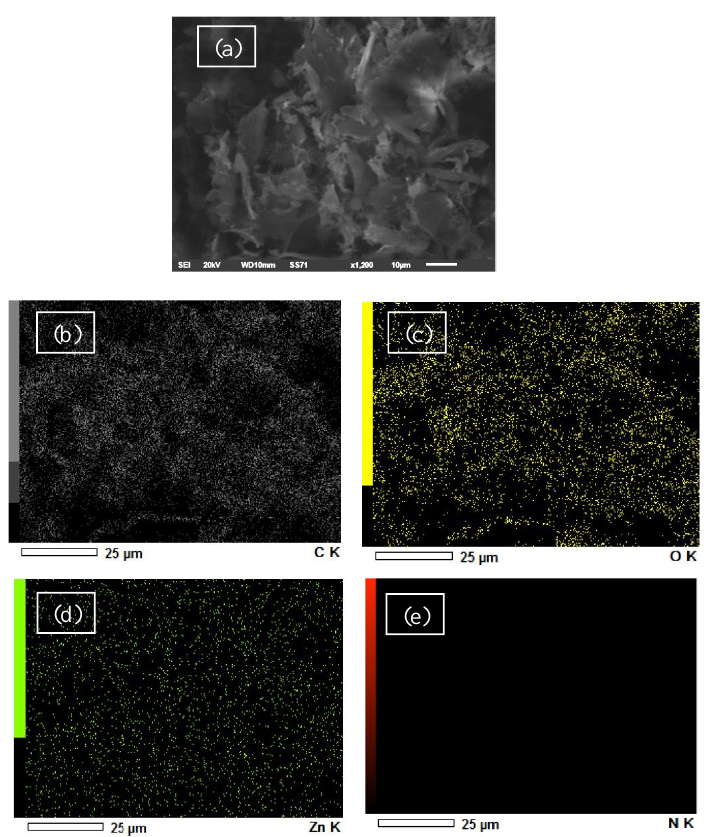
Figure 8. Elemental distribution and mapping analysis of 2Nph-BU-Cs/ZnONPs-5% ( a ) SEM im- age, ( b ) carbon element, ( c ) oxygen element, ( d ) zinc element, and ( e ) nitrogen element.